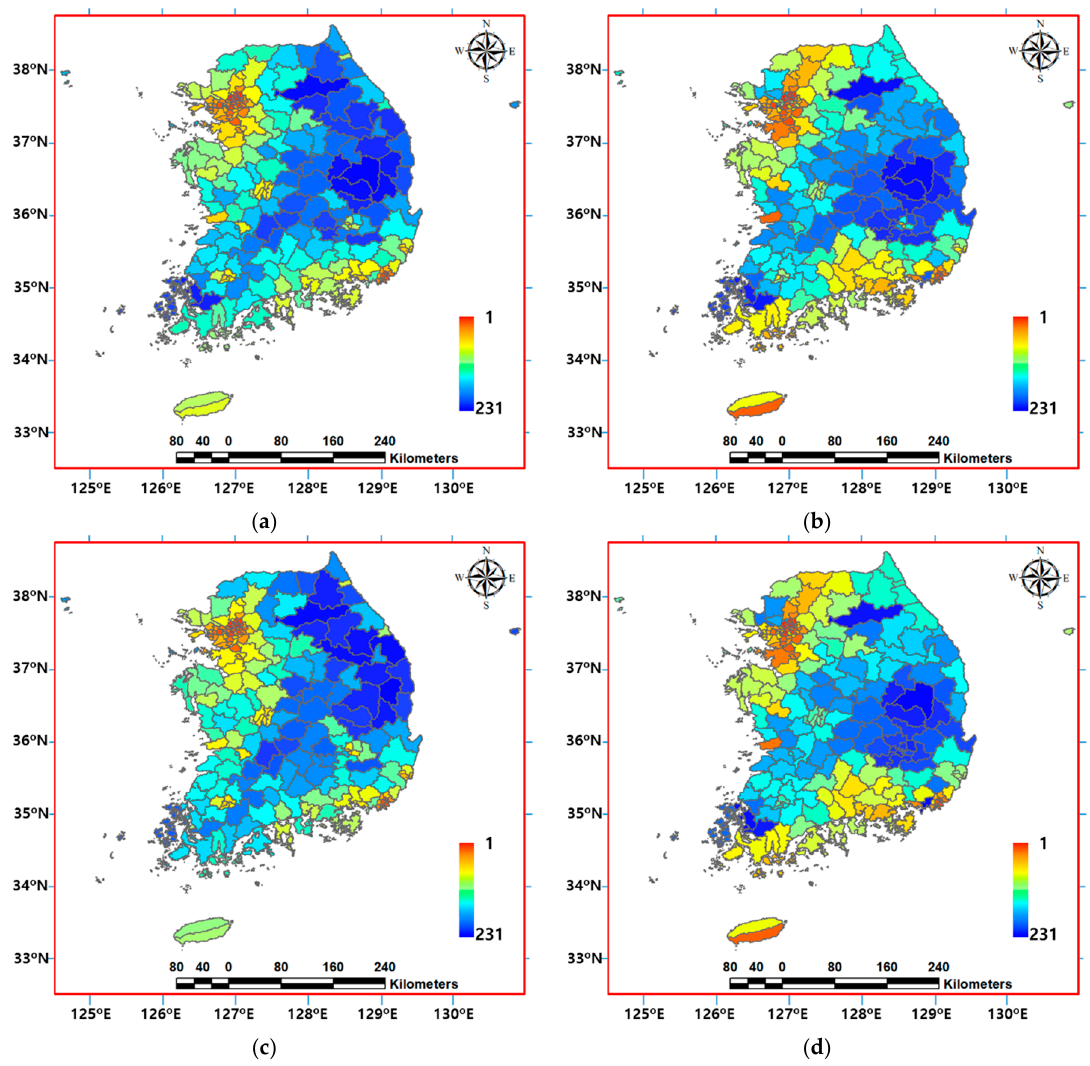
Figure 4. Spatial distribution of the four flood vulnerability outcomes for the study site: ( a ) Raking orders from FVI 1 ; ( b ) raking orders from FVI 2 ; ( c ) raking orders from FVI 3 ; and ( d ) raking orders from FVI 4